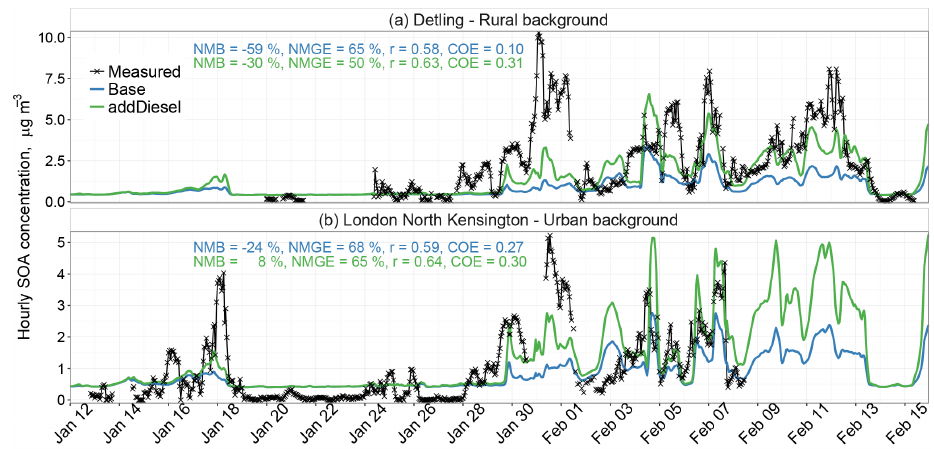
Figure 13. Time series of measured and modelled hourly average concentrations at (a) the Detling rural background site, and (b) the London North Kensington urban background site during the winter 2012 IOP. Note the different scales on the y